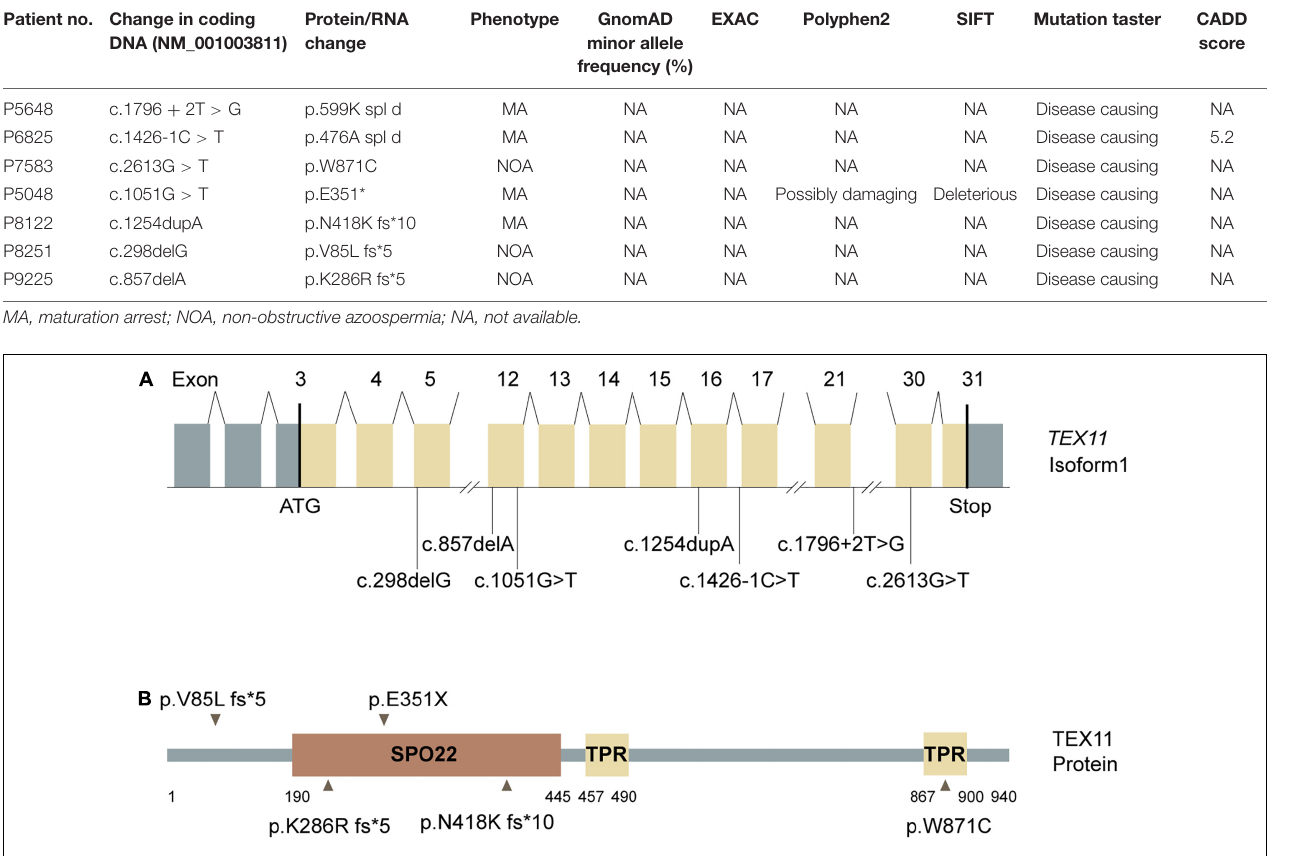
FIGURE 2 | Testis-expressed gene 11 ( TEX11) mutations detected in men with azoospermia. (A) The genomic structure of TEX11, with mutations mapped to isoform 1 (GenBank accession number, NM 001003811.1). Gray rectangles represent non-coding exons, and yellow rectangles represent coding exons. The coding sequence of the gene begins at nucleotides that encode a start codon in exon 3 and ends in exon 31 at a stop codon. All mutations detected in men with azoospermia are shown. (B) The predicted TEX11 domains with multiple tetratricopeptide repeat (TPR)–containing regions (amino acid positions 457–490 and 867–900), and a sporulation domain (SPO22) meiosis-specific motif (amino acid positions 190–445). Mutations in the coding region (black arrowheads) and splicing changes (black lines) are located in predicted